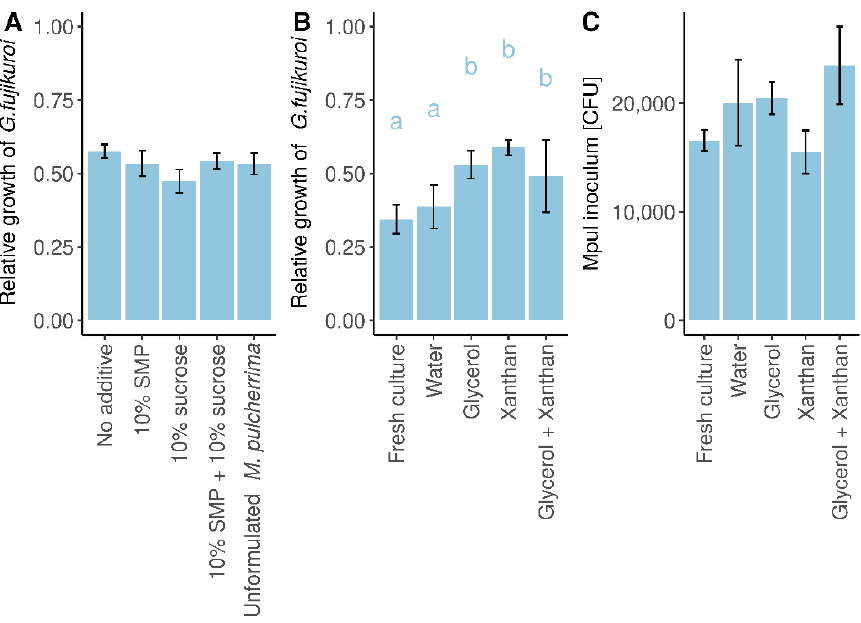
Figure 5. Formulated M. pulcherrima cells retain their antagonistic activity against G. fujikuroi . The biocontrol activity of M. pulcherrima cells stored in different dry ( A ) or liquid ( B ) formulations was tested against G. fujikuroi . As a standard, unformulated cells from an agar plate or an overnight culture of M. pulcherrima were tested. Cell densities were adjusted to obtain similar numbers of colonies on plates ( C ). Fungal growth was evaluated after 4 days of incubation at 22 °C. The means and standard errors of four replicates are shown. Letters indicate statistical significance determined by one-way ANOVA with Tukey ’ s multiple comparisons test and Benjamini – Hochberg correction ( p < 0.05). There were no significant differences for the formulations in panels ( A ) and ( C ).